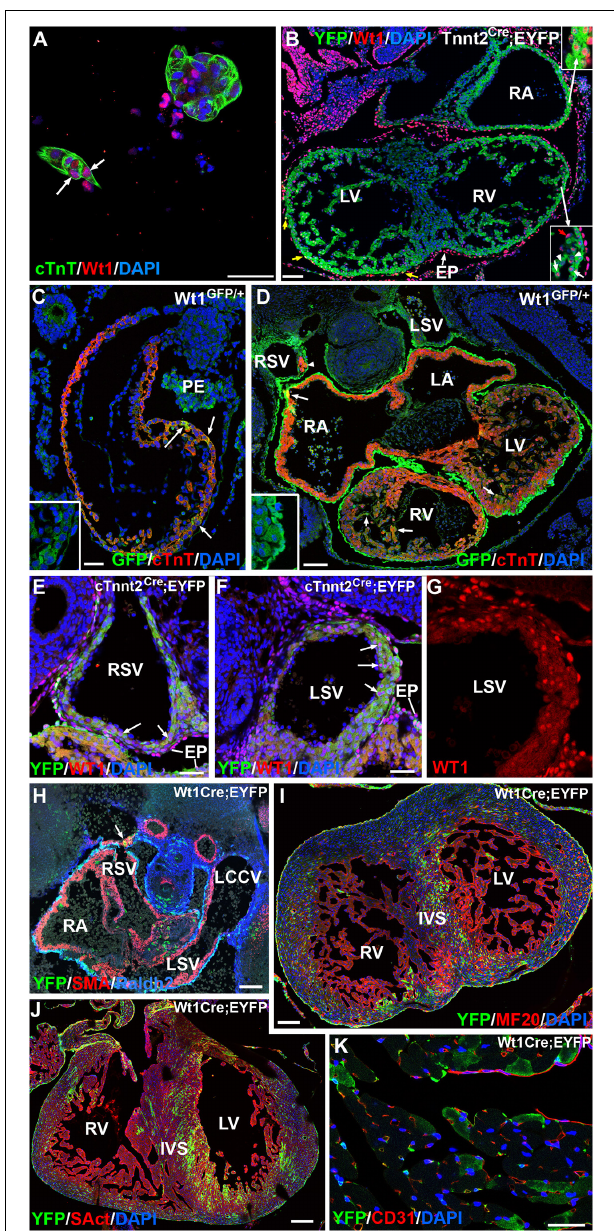
FIGURE 2 | WT1 expression in cardiomyocytes. Representative images obtained from the analysis of > 30 embryos. (A) Immunolocalization of protein WT1 in cultured cardiomyocytes characterized by cardiac troponin expression (arrow) and obtained from an E10.5 embryo. (B) Immunolocalization of protein WT1 in an E11.5 Tnnt2 Cre ;EYFP embryo. WT1 (red staining) is localized in some cardiomyocytes (inserts). Epicardial cells (EP) show expression of the protein WT1, and a few derive from a cardiac troponin-expressing lineage (yellow arrows). RA: right atrium; LV, RV: left and right ventricle, respectively. (C,D) WT1 GFP / + embryos, E9.5 and E11.5, respectively. Expression of the reporter reveals WT1 promoter activation in a number of cardiomyocytes of these early embryos. Colocalization with cardiac troponin (cTnT) is shown by arrows. The inserts show the separate GFP channel. Insert in (D) shows some GFP-expressing cardiomyocytes located in the wall of the right sinus venosus (arrowhead). LA, LV: left atrium and ventricle; PE: proepicardium; LSV, RSV: